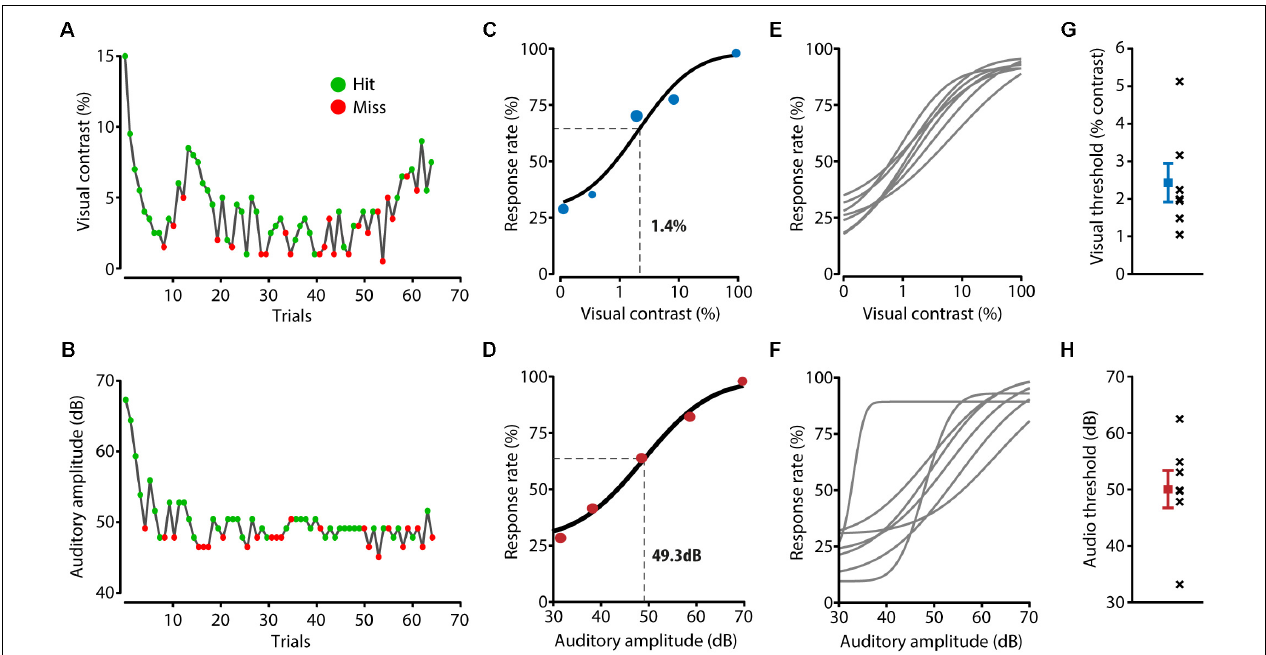
FIGURE 2 | Detection performance for unisensory stimuli. (A,B) During a behavioral session, two adaptive staircase procedures were running in parallel for presenting visual (A) and auditory (B) stimuli around the perceptual threshold of the mouse. Green dots indicate trials in which the mouse licked in response to the stimulus, red dots indicate trials during which no response registered. (C) The visual perceptual threshold was determined by fitting a psychometric function to the response rate calculated for the binned visual stimulus contrast. Visual contrast was log 10 transformed to allow for a better fit. The example mouse shown here has a visual threshold of 1.4%, determined as the point half way the fitted curve. (D) Example psychometric function and threshold calculation for auditory trials. (E,F) Fitted psychometric functions for all mice ( n = 7). (G) Visual thresholds for all individual mice (black crosses) and the mean and SEM (in blue) over mice. (H) Auditory thresholds for all mice (black crosses) and the mean and SEM (in red) over